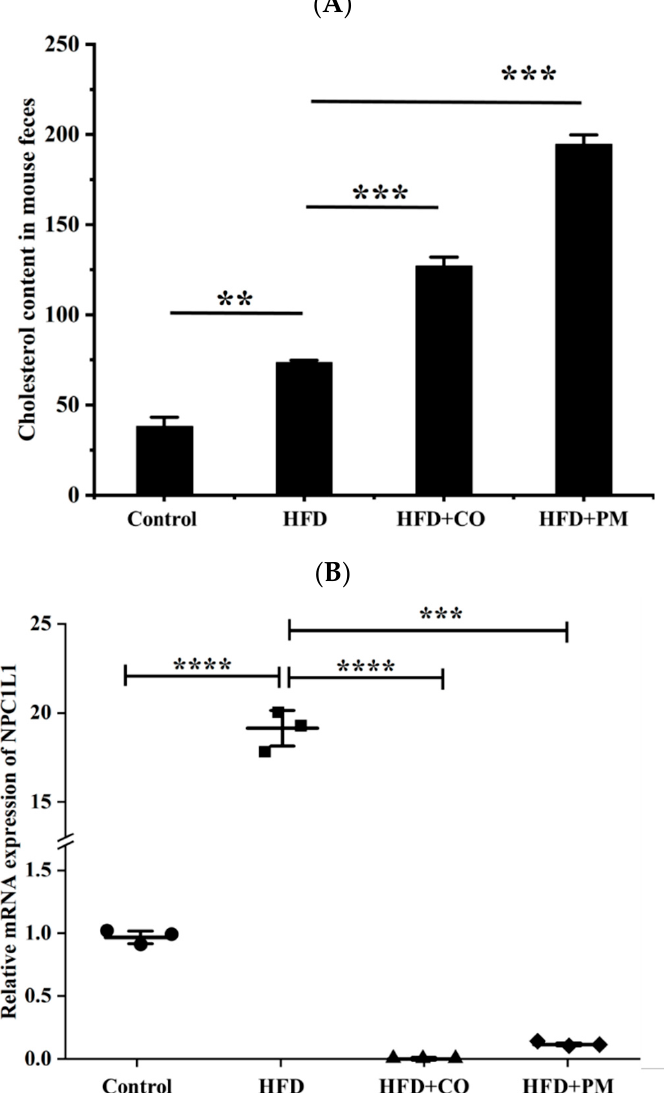
Figure 10. Graphical representation of the cholesterol contents in moue feces after treating the mice with the different formulations while feeding with HFD ( A ) and the mRNA levels of NPC1L1 genes in the mouse intestines after treating the mice with the different formulations ( B ). ** p < 0.01, *** p < 0.001, **** p < 0.0001.